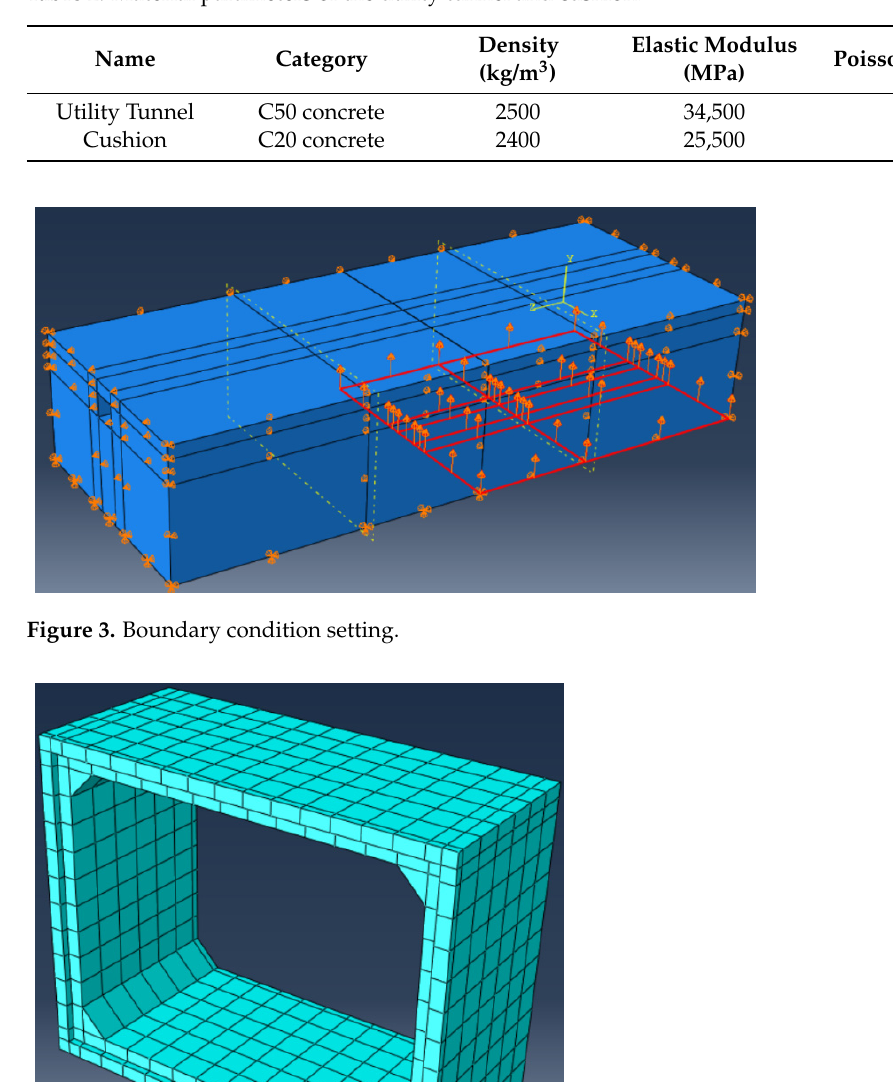
Figure 5. Meshing of the soil. 3. Response Analysis of the Utility Tunnel The numerical simulation can be divided into four working conditions according to the different influencing factors studied, and these specific working conditions are shown in Table 3. Table 3. Working conditions of the influencing factors analysis. Working Condition